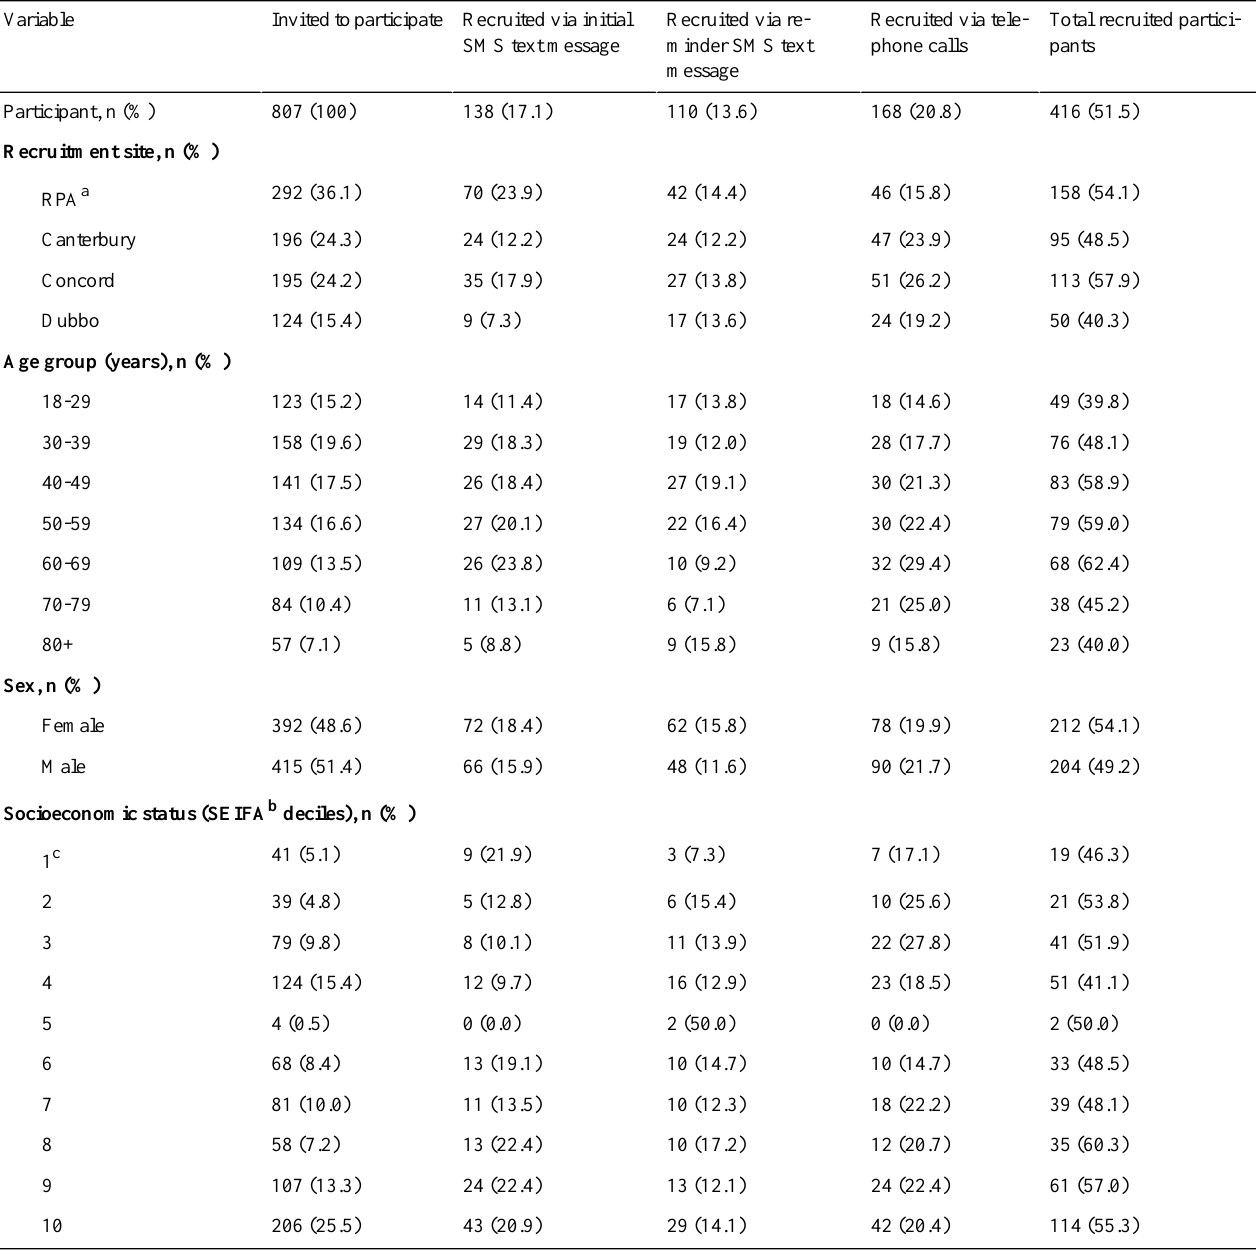
Table 1. Recruitment rates by response method, grouped by recruitment site, age, sex, and socioeconomic status (N=807).